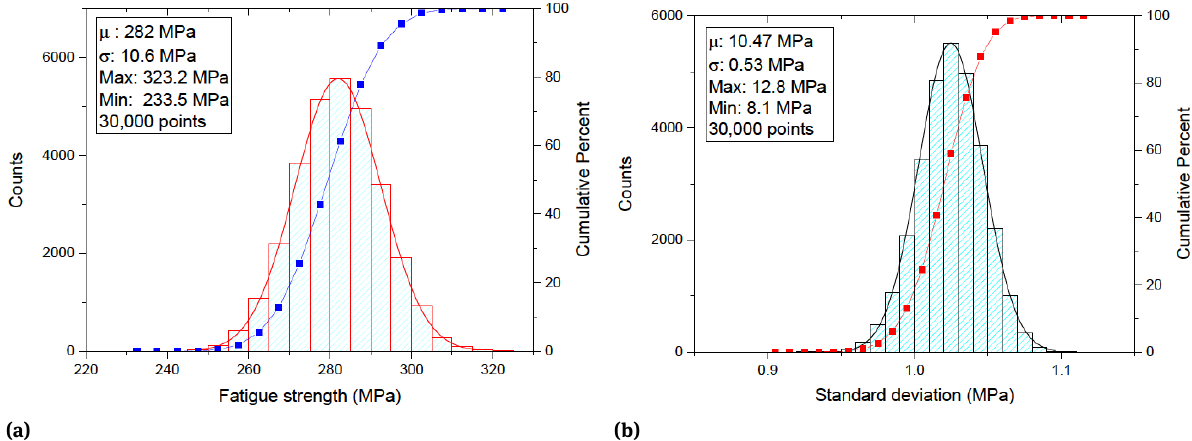
Figure 7: Monte Carlo simulation for 30,000 points for: (a) Normal distribution function of fatigue strength, and (b) Log-normal distribution function of standard